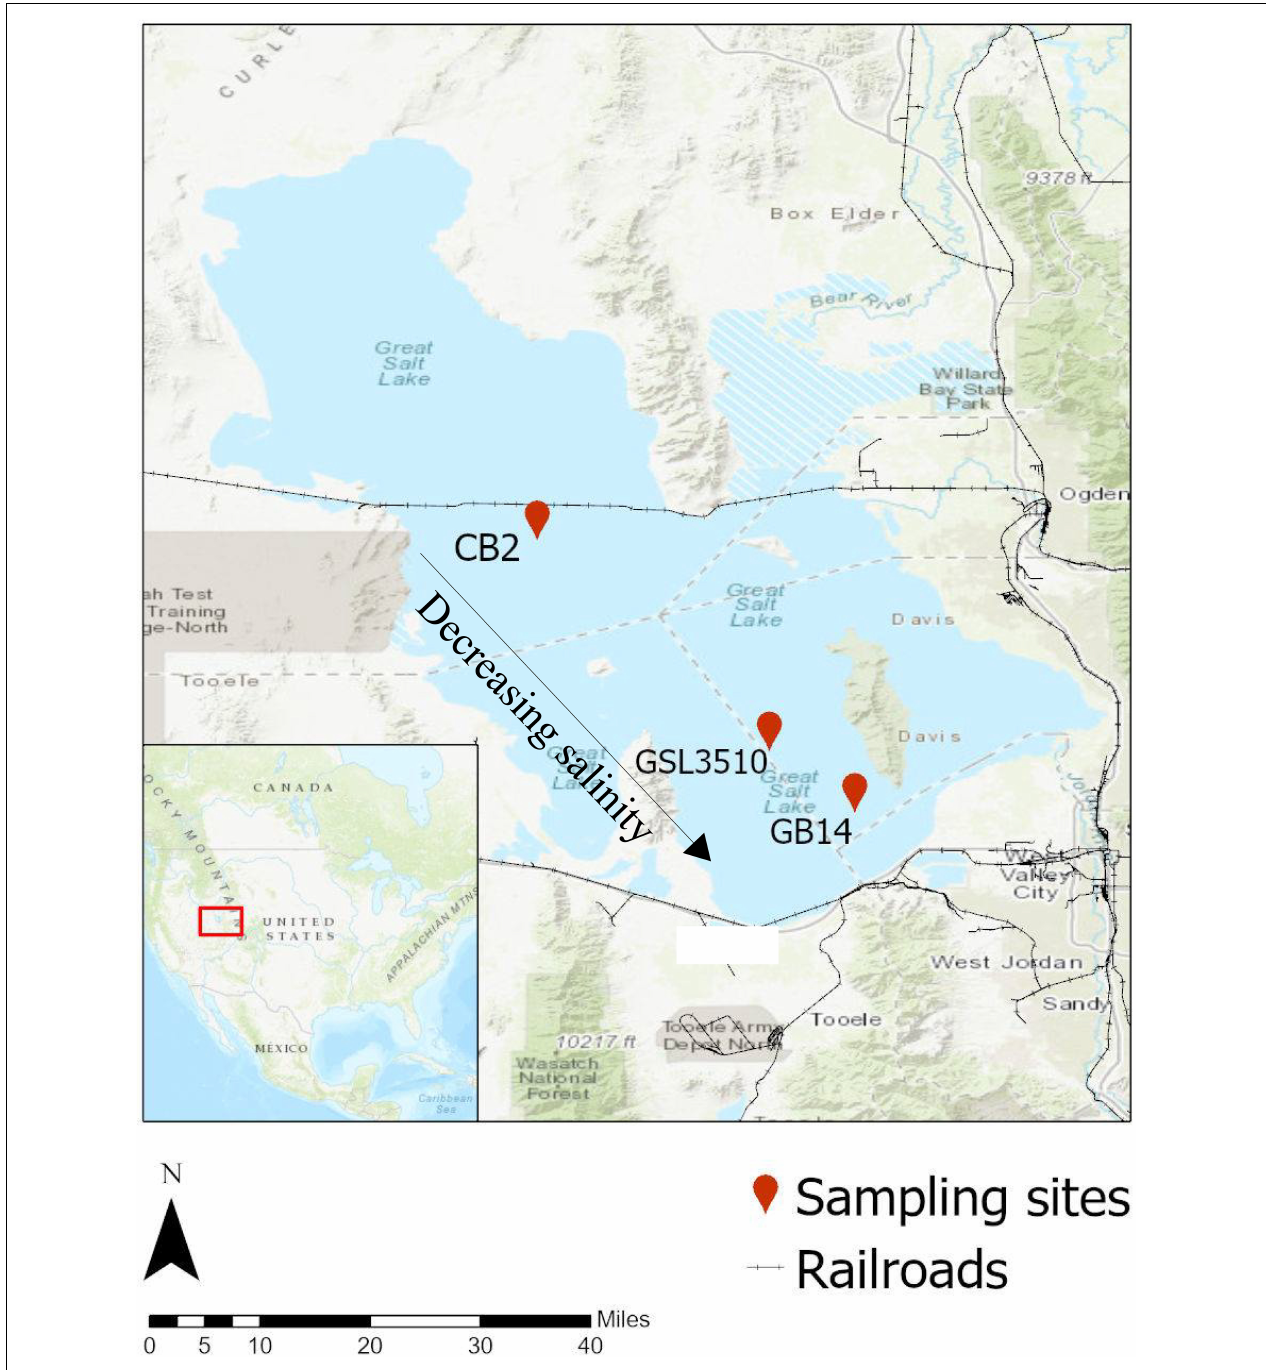
FIGURE 1 | Location of study areas in the Great Salt Lake (GSL). The three sites are (i) CB-2, 12.3 miles North-West of Carrington Island (41 ◦ 10 (cid:48) 32.3 (cid:48)(cid:48) N, 112 ◦ 39 (cid:48) 11.9 (cid:48)(cid:48) W); (ii) GSL 3510, 6 miles West of Antelope Island (40 ◦ 53 (cid:48) 56.0 (cid:48)(cid:48) N, 112 ◦ 20 (cid:48) 56.0 (cid:48)(cid:48) W); and (iii) GB-14, 6.8 miles North of Great Salt Lake Marina (40 ◦ 49 (cid:48) 06.2 (cid:48)(cid:48) N, 112 ◦ 14 (cid:48) 13.6 (cid:48)(cid:48) W). Source: Background Map (Topographic Base Map, ESRI 2020).